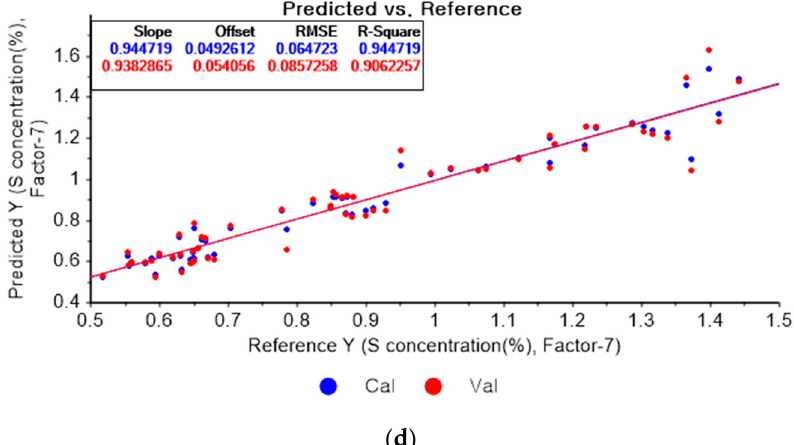
Figure 13. PLSR model of sulfur concentration with ( a ) the original data and PLSR models pre- processed by SG smoothing using ( b ) third-order polynomial with three points, ( c ) third-order polynomial with five points, and ( d ) third-order polynomial with seven points.